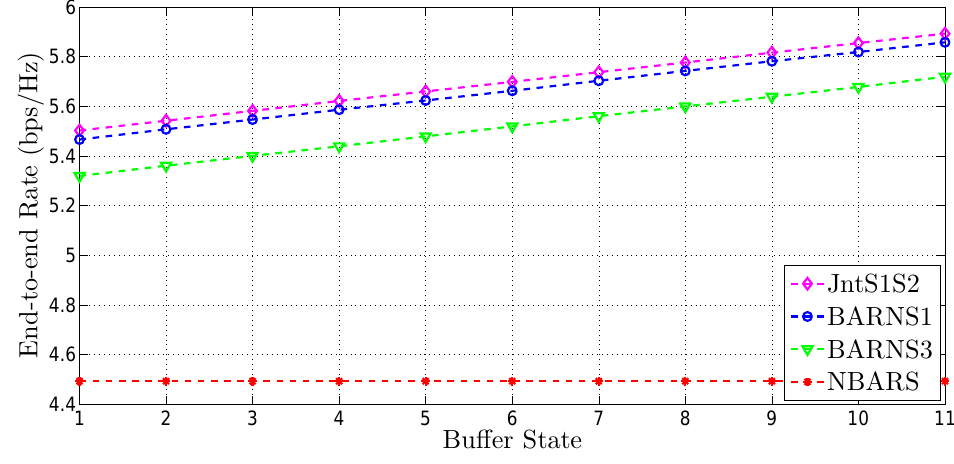
Figure 5. Throughput (bps/Hz) versus the state of the